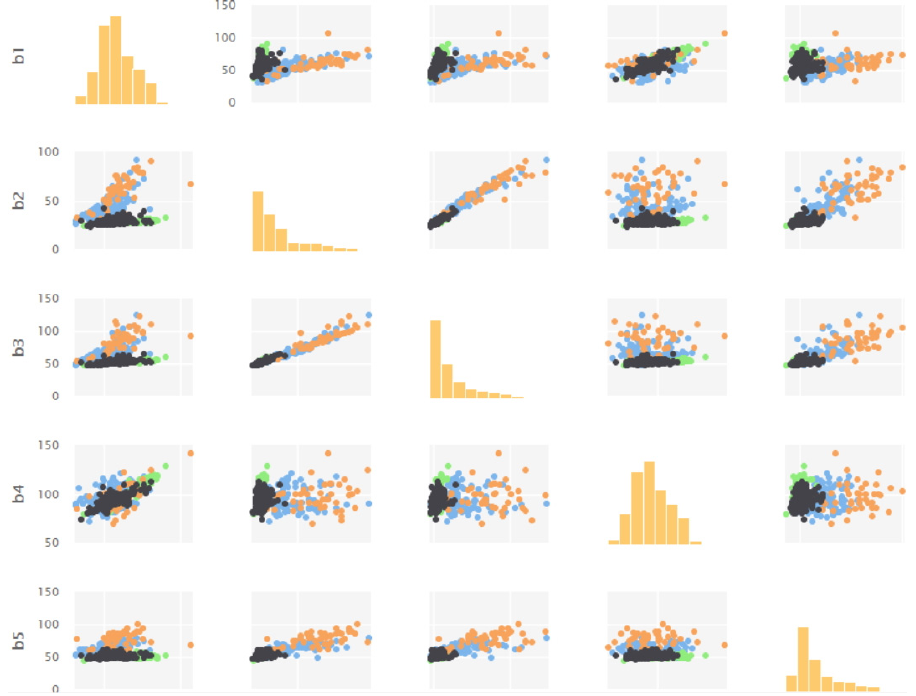
Figure 2. Scatterplot of remote sensing (RS) data showing that the classes (land-types) are mixed and reflected across different data features.